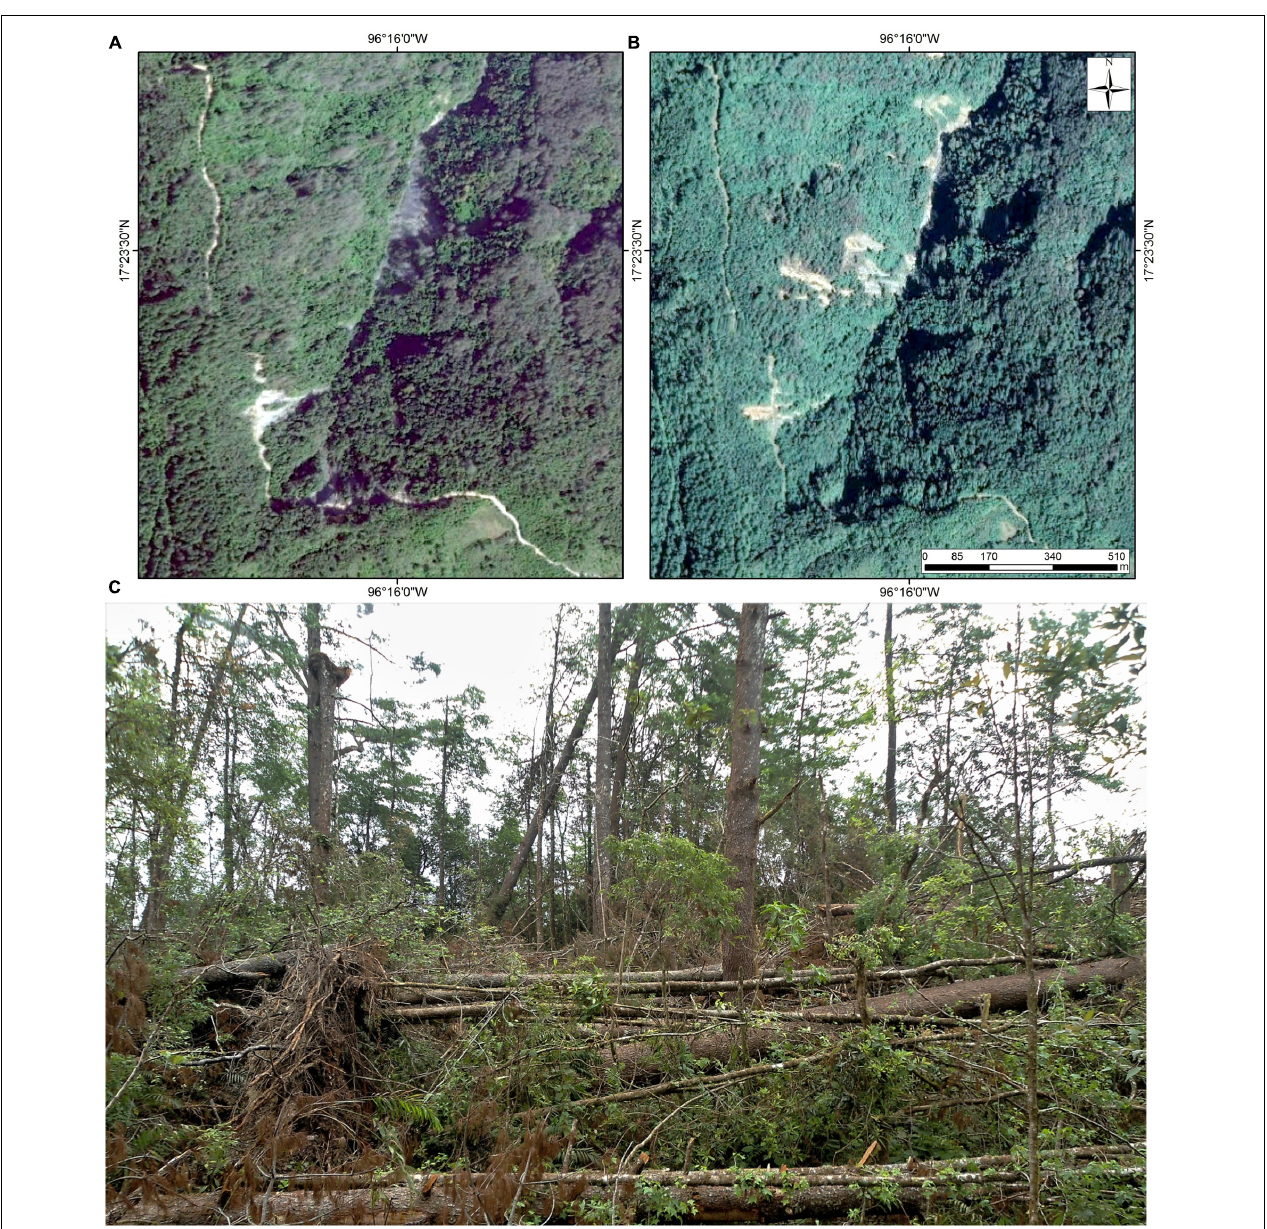
FIGURE 4 | Satellite images taken before (2014) (A) , and after a gust that took place on March 9th, 2016 (B) . (C) in situ photograph of one of the affected sites in Sierra Norte, Oaxaca (photograph by Hermilo Martínez). Several sites were simultaneously affected by this strong wind in Sierra